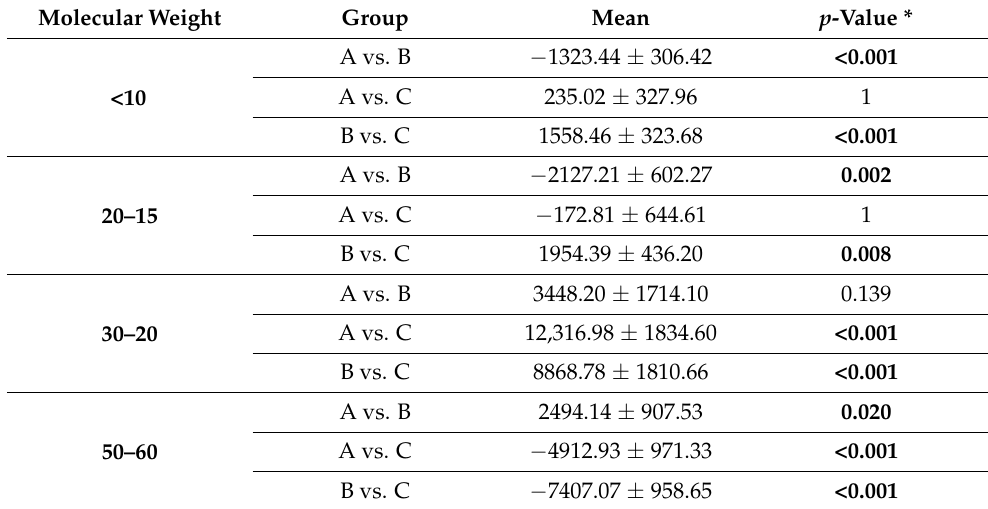
Table 4. Pairwise comparisons of the three groups regarding the concentrations of proteins with different molecular weights.